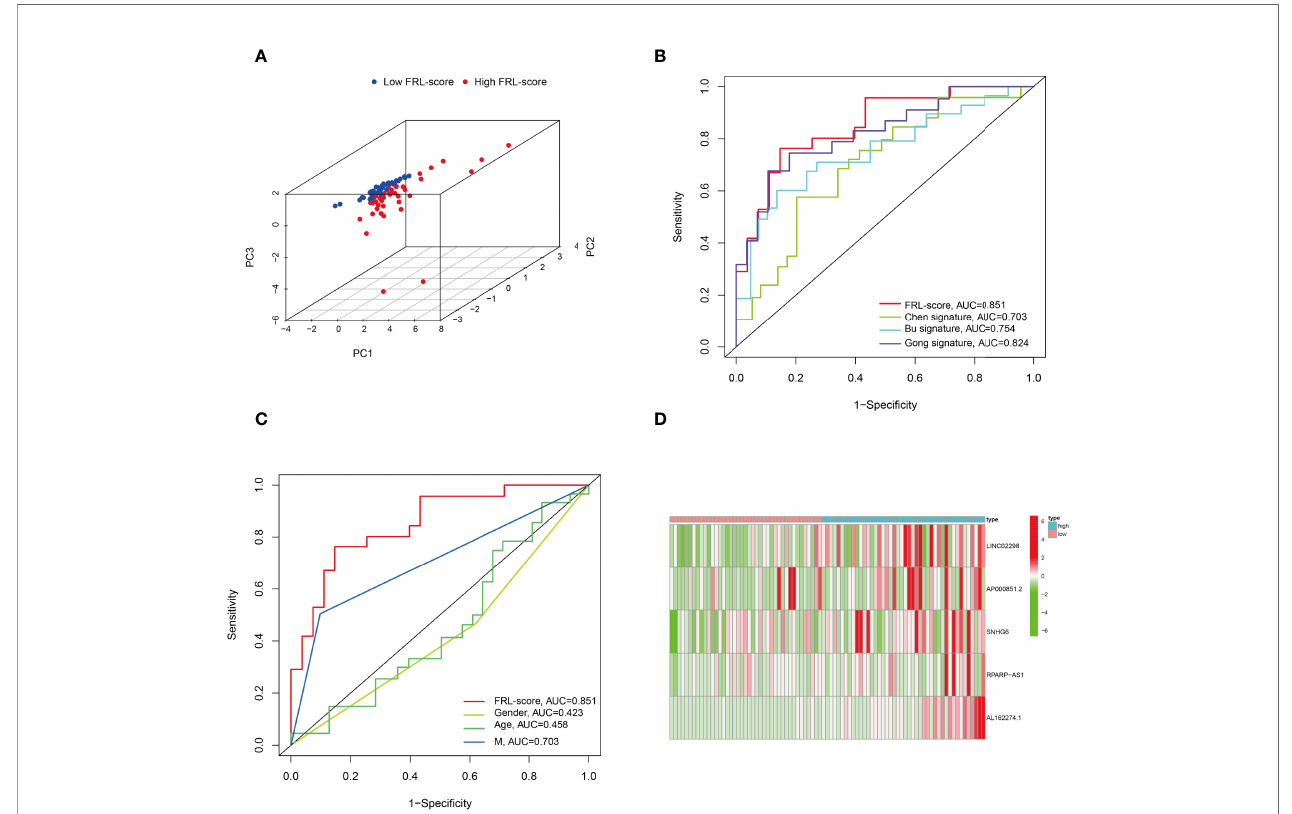
FIGURE 5 | Principal component analysis and comparison of FRL prognostic signature with different prognostic signatures and clinical features. (A) Principal component analysis in the TARGET cohort. (B) Comparison of various lncRNA prognostic signatures in the TARGET cohort. (C) Comparison of FRL prognostic signature with different clinical features. (D) Expression heatmap of the fi ve ferroptosis-related